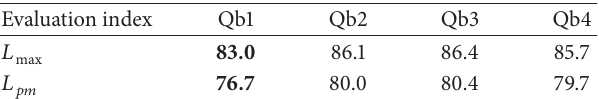
Table 7: Comparison of the SPL indices for different bogie skirt board designs